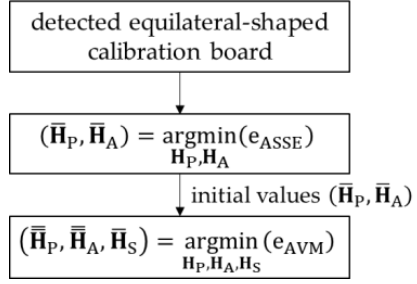
Figure 8. The procedure for the AVM error minimization, where e AVM = e LSSE + e AME